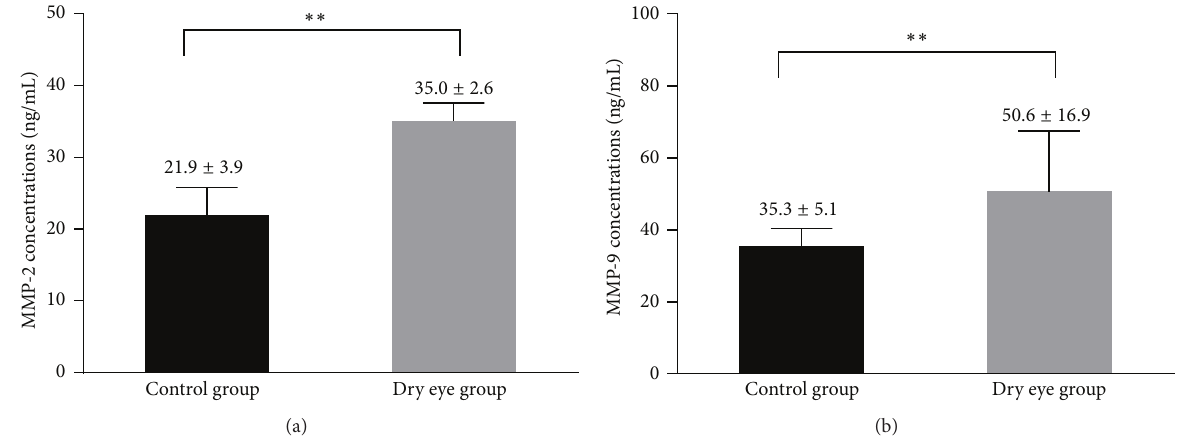
Figure 2: The concentrations of MMP-2 (a) and MMP-9 (b) in tears from patients with dry eye and normal controls. Values were presented as mean ± SD. ∗∗ Significant difference with 𝑃 < 0.001